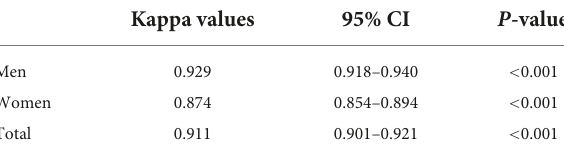
TABLE 3 The consistency of diagnosis of MetS according to WC and